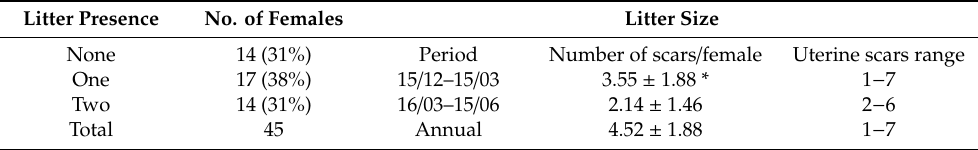
Figure 2. A uterus after the treatment to evidence uterine scars. The arrows highlight more recent darker scars, while the arrowheads indicate older, lighter-coloured scars. Table 3. Litter size estimated according to the uterine scar analysis.